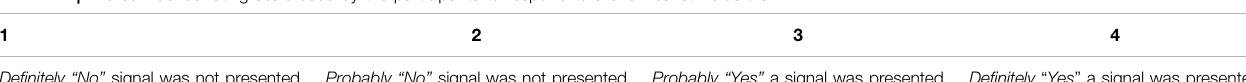
TABLE 2 | The con fi dence rating scale used by the participants to respond to a chemical stimulus